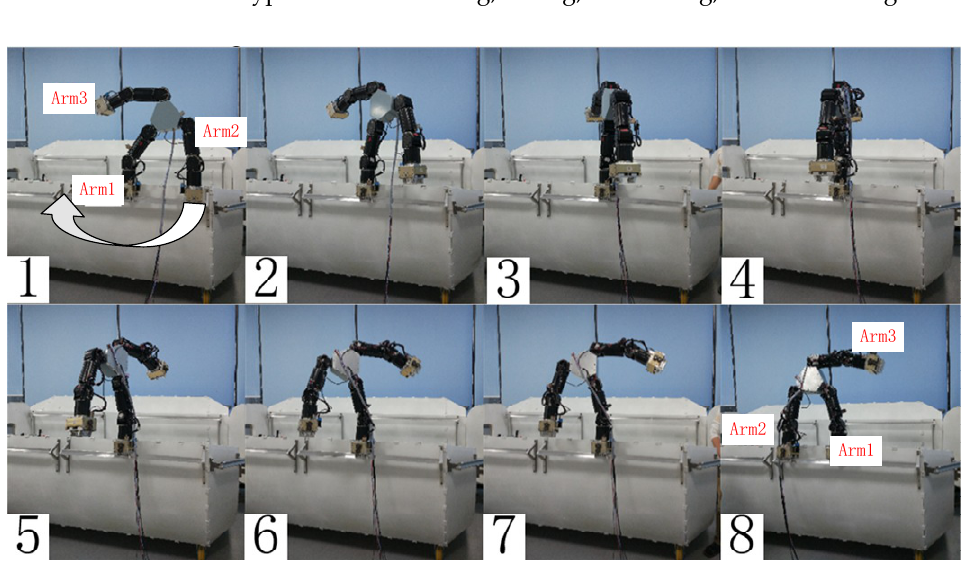
Figure 12. Walking mode. In this mode, arm 2 is initially located to the right of arm 1. During walking, arm 1 grasps the handrail, then arm 2 releases, the robot rotates 180° around arm 1. Then arm 1 reaches the left side of arm 2, and arm 2 grasps the armrest to complete one step of the robot. In the next step of walking, the robot rotates around arm 2 to complete the walking action. Arm 1 and arm 2 move alternately to achieve continuous walking of the robot.